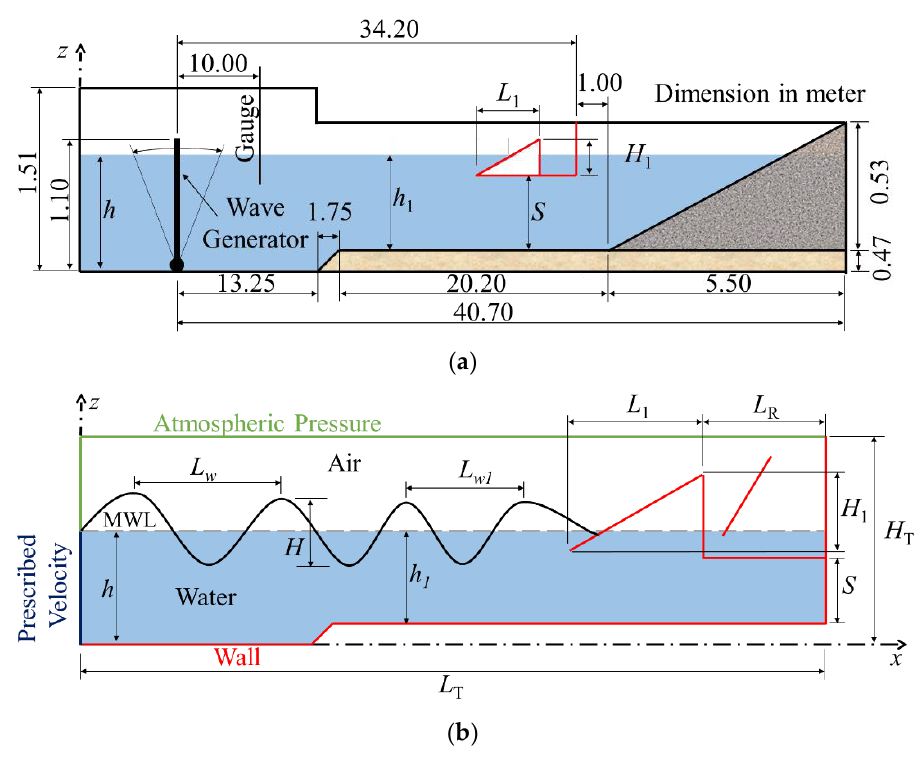
Figure 12. Illustrations of: ( a ) Wave channel; ( b ) Computational domain. Table 8. MAE, RMSE and l ∞ norm for the free surface elevation ( η ) for the Gauge.